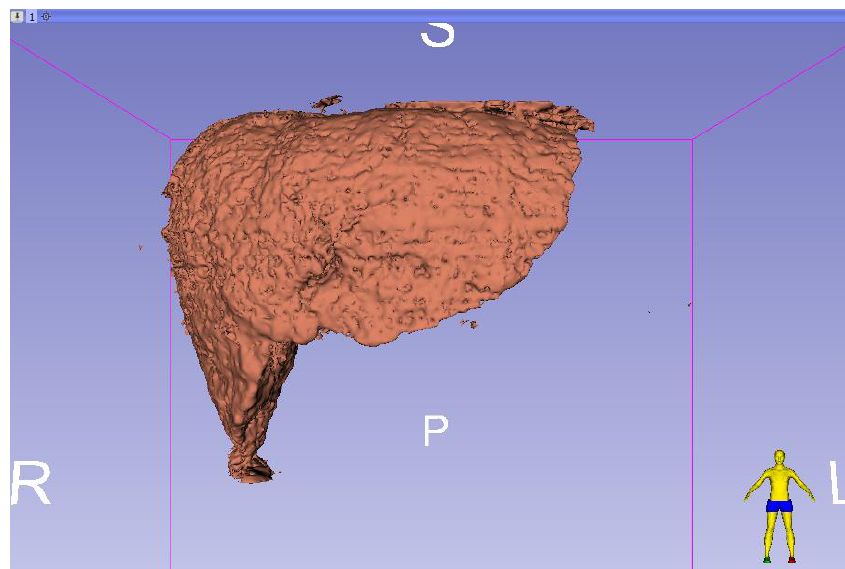
Figure A5: Segmented liver model in 3D